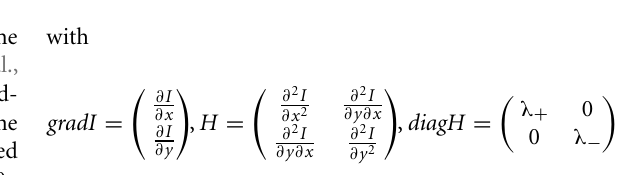
FIGURE 6 | (A) Typical electrophoresis gel images for the RT-PCR analysis for the mRNAs of sex-steroidogenic enzymes ( Srd5a1 : 5 α -reductase type 1, Cyp17a1: P450 (17 α ), and Cyp19a1 : P450arom) and sex hormone receptors ( Ar : AR and Esr1 : ER α ). Each band of PCR product is stained with EtBr and visualized. Lanes labeled with P1 (PD1), P4, P7, P10, P14, W4 (PW4), andW12 represent the PCR products derived from the male rat hippocampus at the corresponding ages.The left-most lane (labeled with